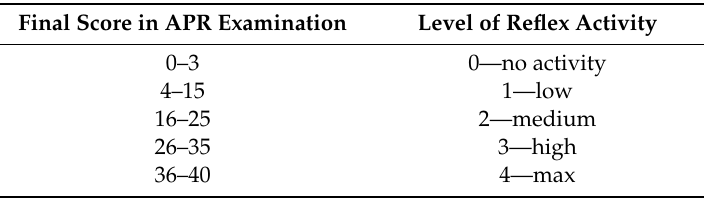
Table 2. The degree of primitive reflex integration